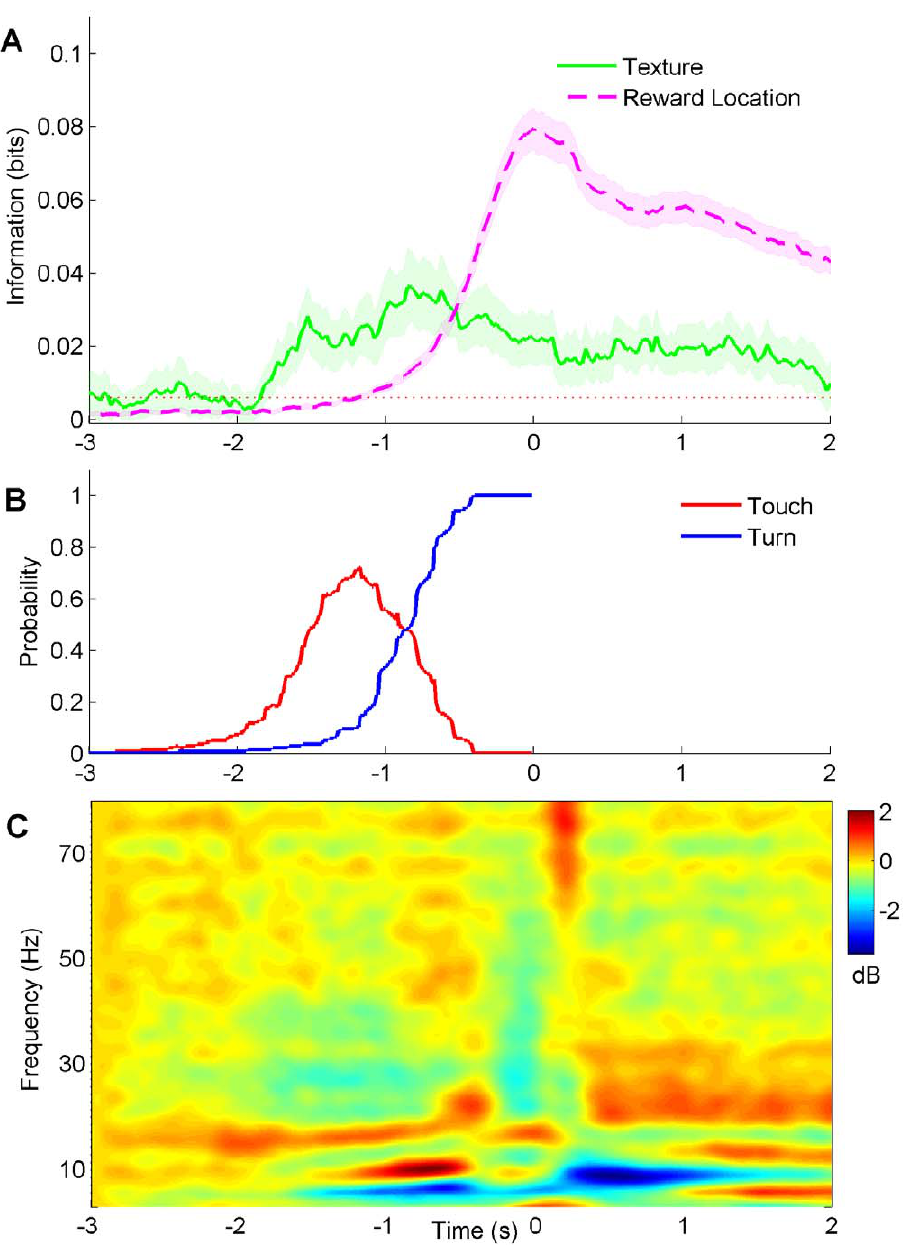
Figure 5. Relation between texture and reward signals, behavior, and local field potential oscillations. (A) Average temporal profile of texture and reward location information among all neurons with statistically significant signals. Horizontal red dotted line denotes average quantity of texture information in the interval 2–3 seconds prior to texture contact. Shaded area is standard error of the mean. (B) Probability distribution of touch and turn epochs in behavior, aligned to reward onset, reproduced from Figure 2C. (C) Event related spectral perturbation of local field potential. Color bar represents change in power in dB relative to the interval 2–3 seconds prior to texture contact.